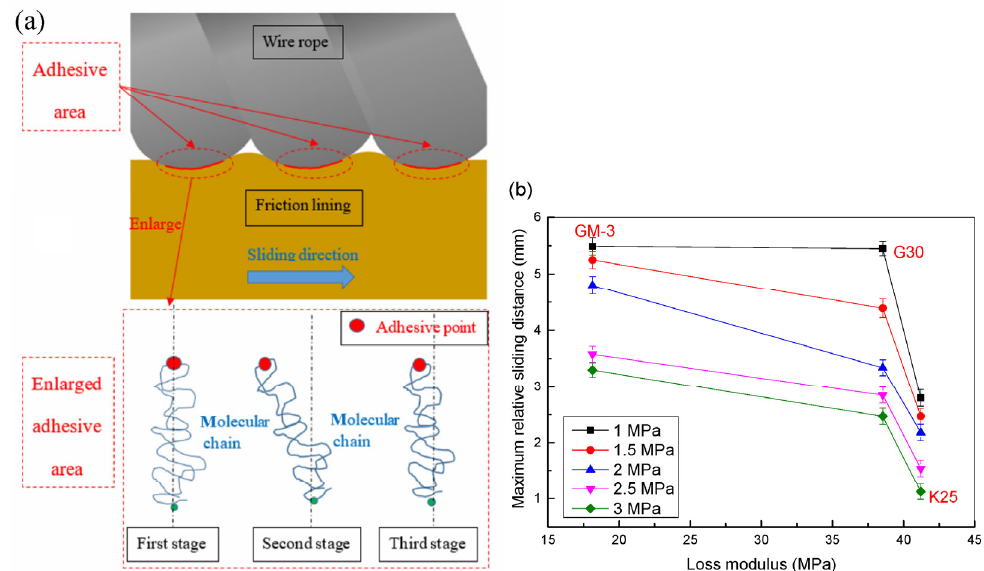
Fig. 13 Adhesion friction mechanism: (a) Diagram of adhesive friction and (b) the relationship between loss modulus and maximum relative sliding